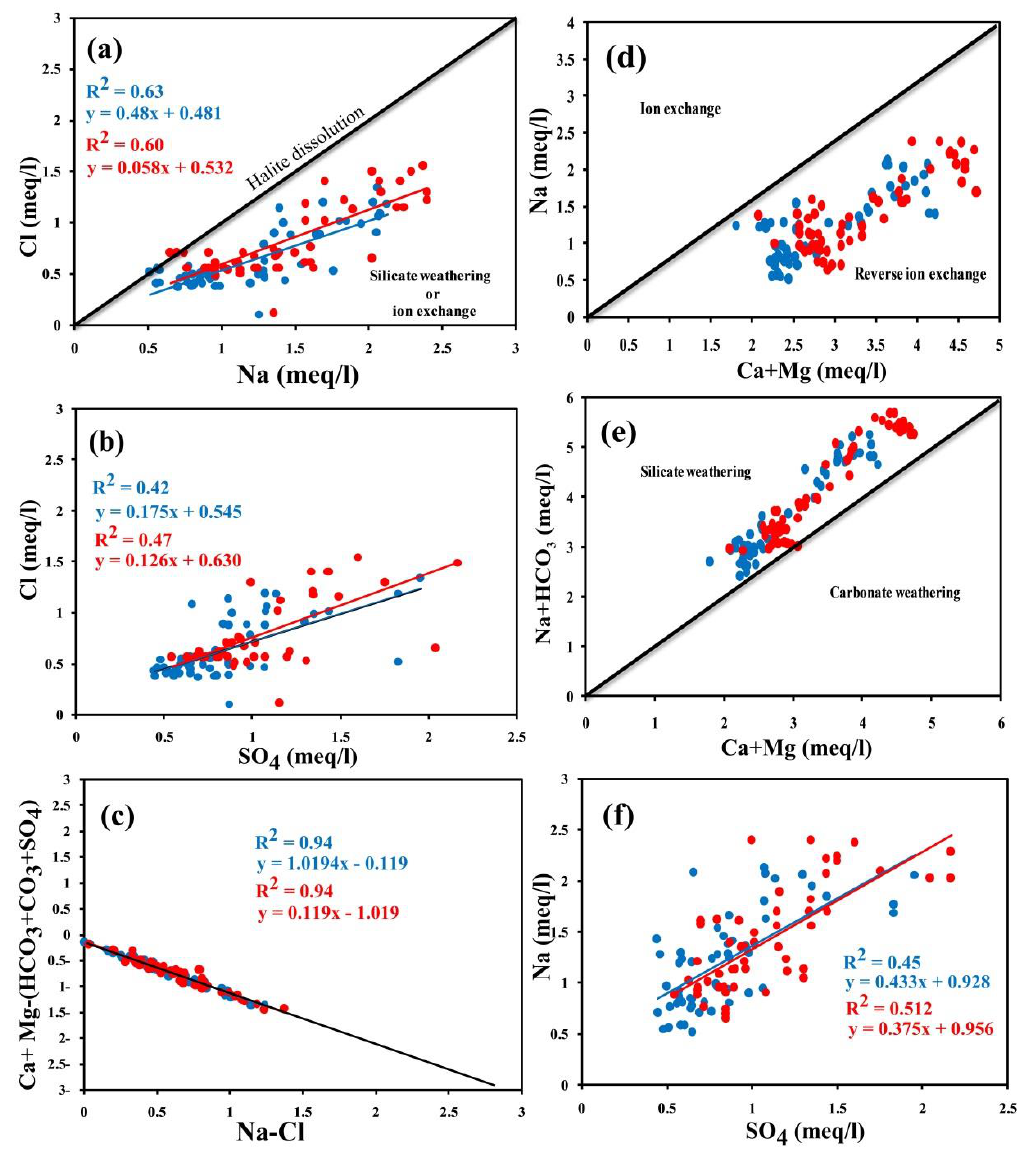
Figure 3. Major cations and anions relationships with ionic ratios, ( a ) Na + vs. Cl − , ( b ) Na 2+ vs. SO 42− , ( c ) Na + -Cl − vs. Ca 2+ + Mg 2+ − (HCO 32− + CO 32− + SO 42− ), ( d ) Na + vs. Ca 2+ + Mg 2+ , ( e ) Ca 2+ + Mg 2+ vs. Na + + HCO 32− , ( f ) Na + vs. SO 42− of surface water samples over two years.